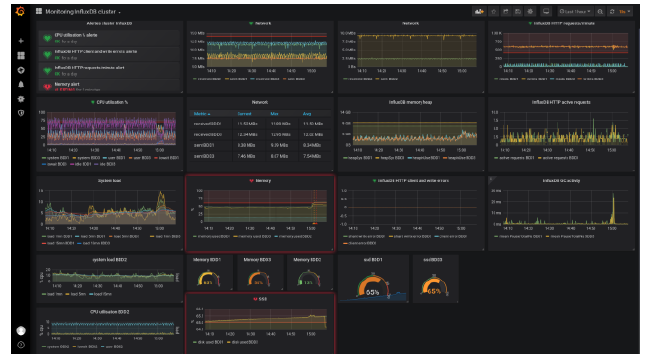
Fig. 7. Grafana dashboard.